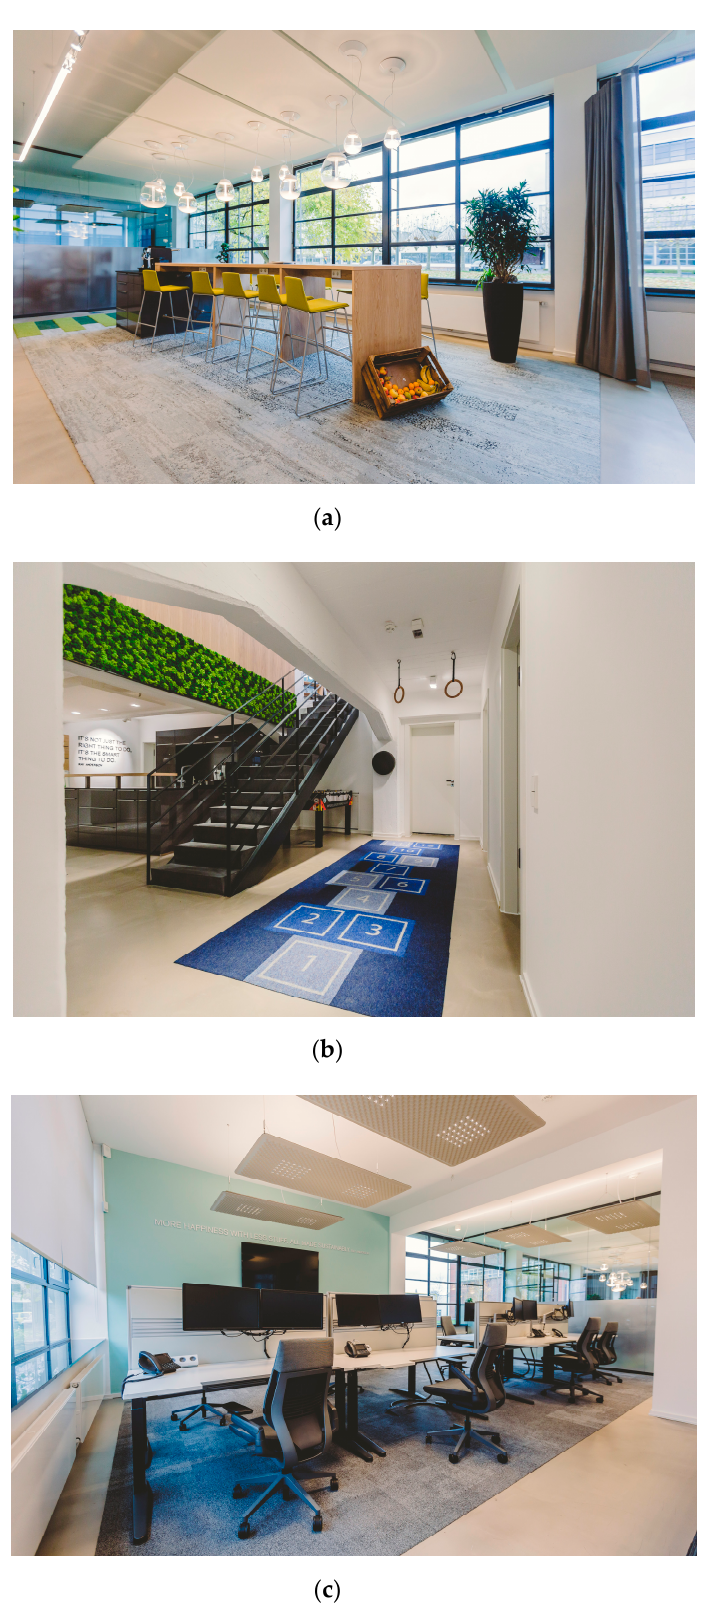
Figure 2. ( a ) New office—public space with counter and counter chairs (images: ©Lichthalle Figure 1. ( a ) New o ffi ce—public space with counter and counter chairs (images: © Lichthalle Krefeld); ( b ) ActiveOffice® features (image: ©Lichthalle Krefeld); ( c ) Employees’ work desks Krefeld); ( b ) ActiveO ffi ce ® features (image: © Lichthalle Krefeld); ( c ) Employees’ work desks (image: © Lichthalle (image: ©Lichthalle Krefeld).